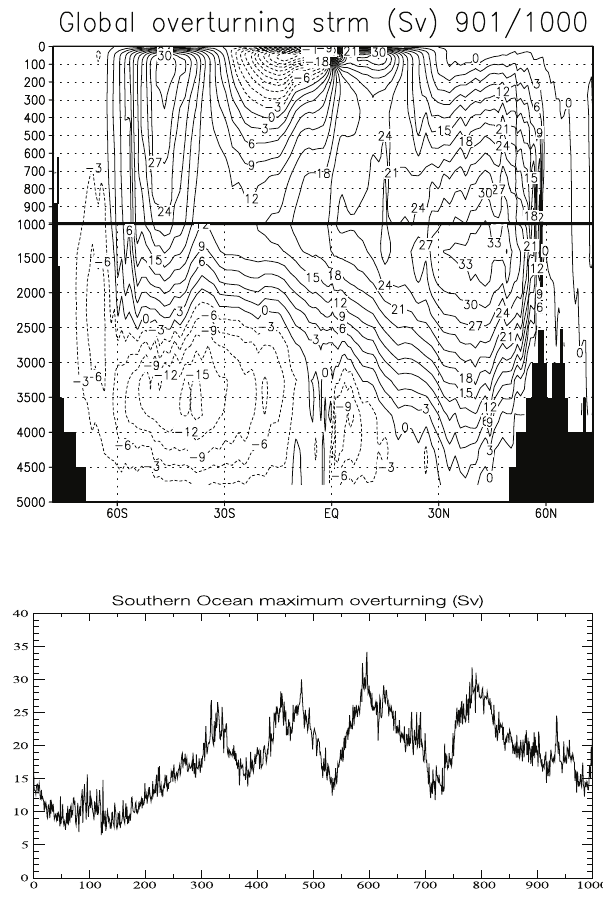
Fig. 5. Top : global overturning circulation mass trans- port stream function (Sv) averaged for the period 901 to 1000. Bottom : maximum mass transport (Sv) of the Antarctic bottom water in function of simulated year.